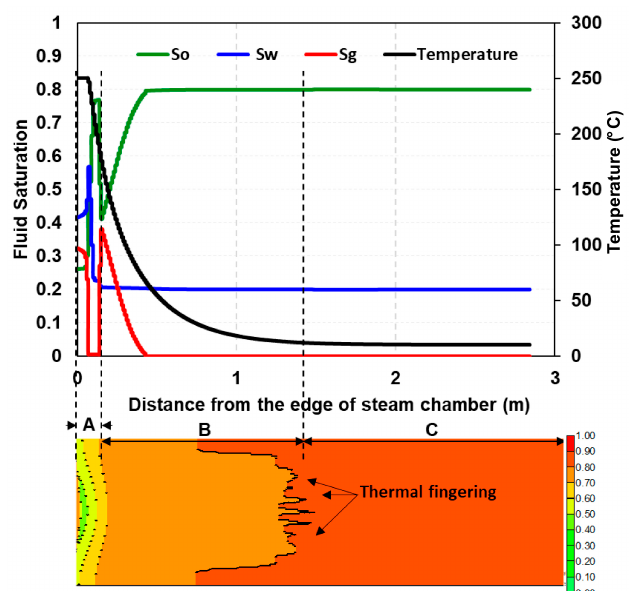
Figure 8. Phase saturations and temperature profiles versus distance together with 2D image of the oil saturation profile (below) indicating distinct fluid regions ( A – C ) observed in a cross section of the VE model. The VE model has been rotated by 90 degrees to the right and the width of the model has been exaggerated twice for clarity.